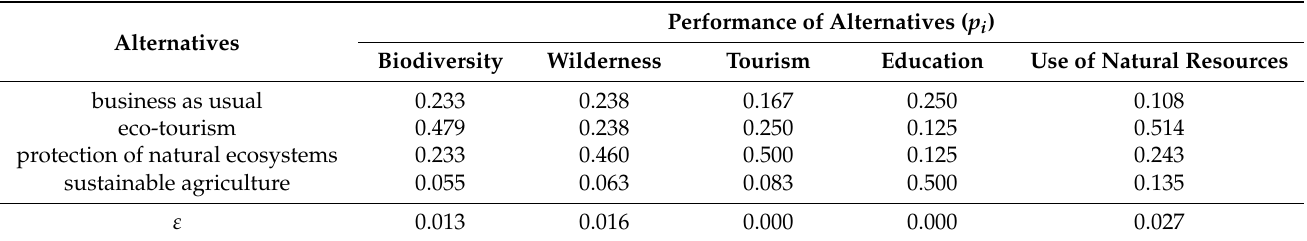
Table 8. Performance of alternatives ( p i ) and consistency measure ( ε )—BW